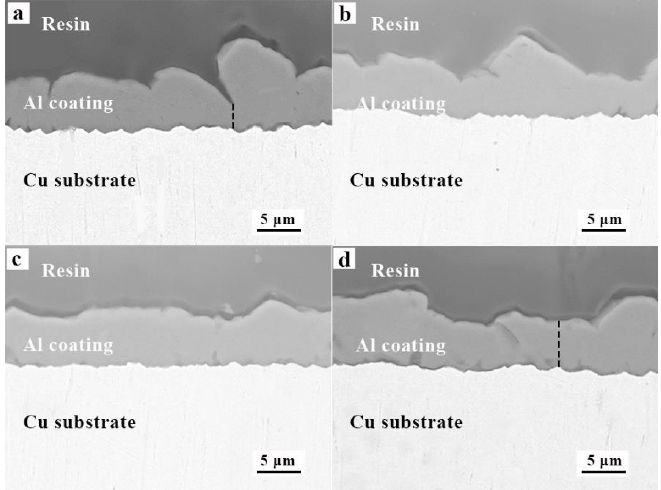
Figure 7. The cross-sectional morphology of the Al coating deposited from the AlCl 3 -NaCl-KCl molten salts electrolyte with different additives, ( a ) no additives, ( b ) 1% TMACl, ( c ) 1% TMACl + 5% NaI and ( d ) 1% TMACl + 10% NaI.